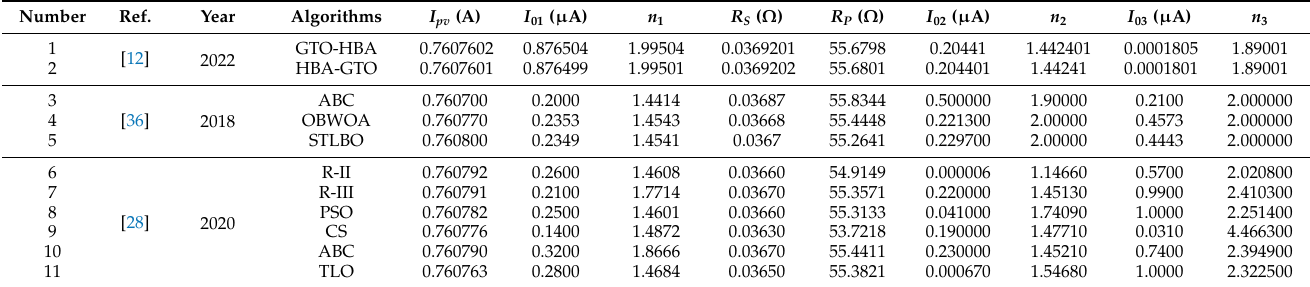
Table 2. TDM parameters for RTC France cell.